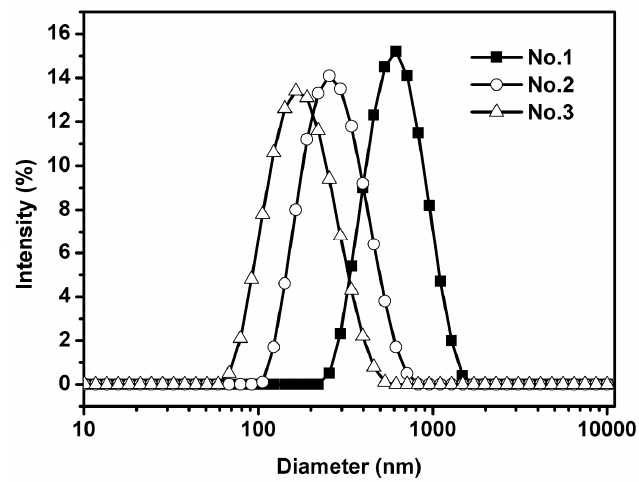
Figure 1. Droplet diameter distributions of three lipid-based emulsions with varying droplet size encapsulated with sodium caseinate (mean droplet sizes of No. 1, No. 2, and No. 3 are 556, 265, and 170 nm, respectively). The data were expressed as mean ± standard with three independent replicates. Table 2. Characteristics of three different droplet size lipid-based emulsions (mean ± STD, n = 3) α .